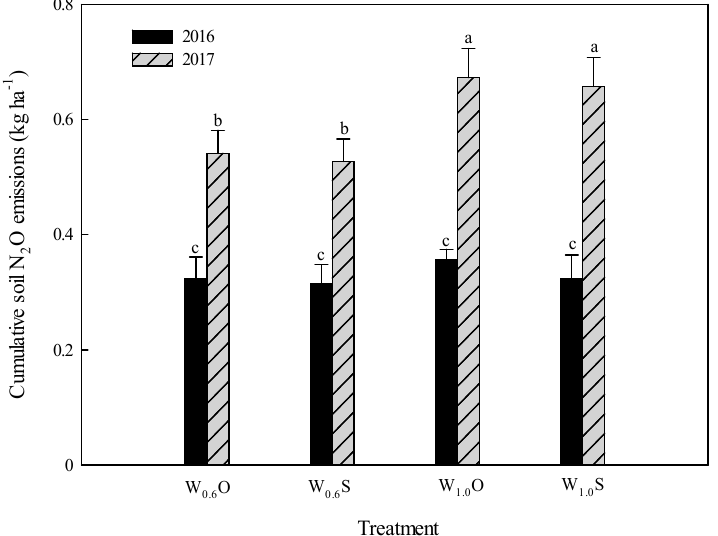
Figure 4. Cumulative soil N 2 O emissions among treatments in the greenhouse tomato-growing seasons of 2016 and 2017.